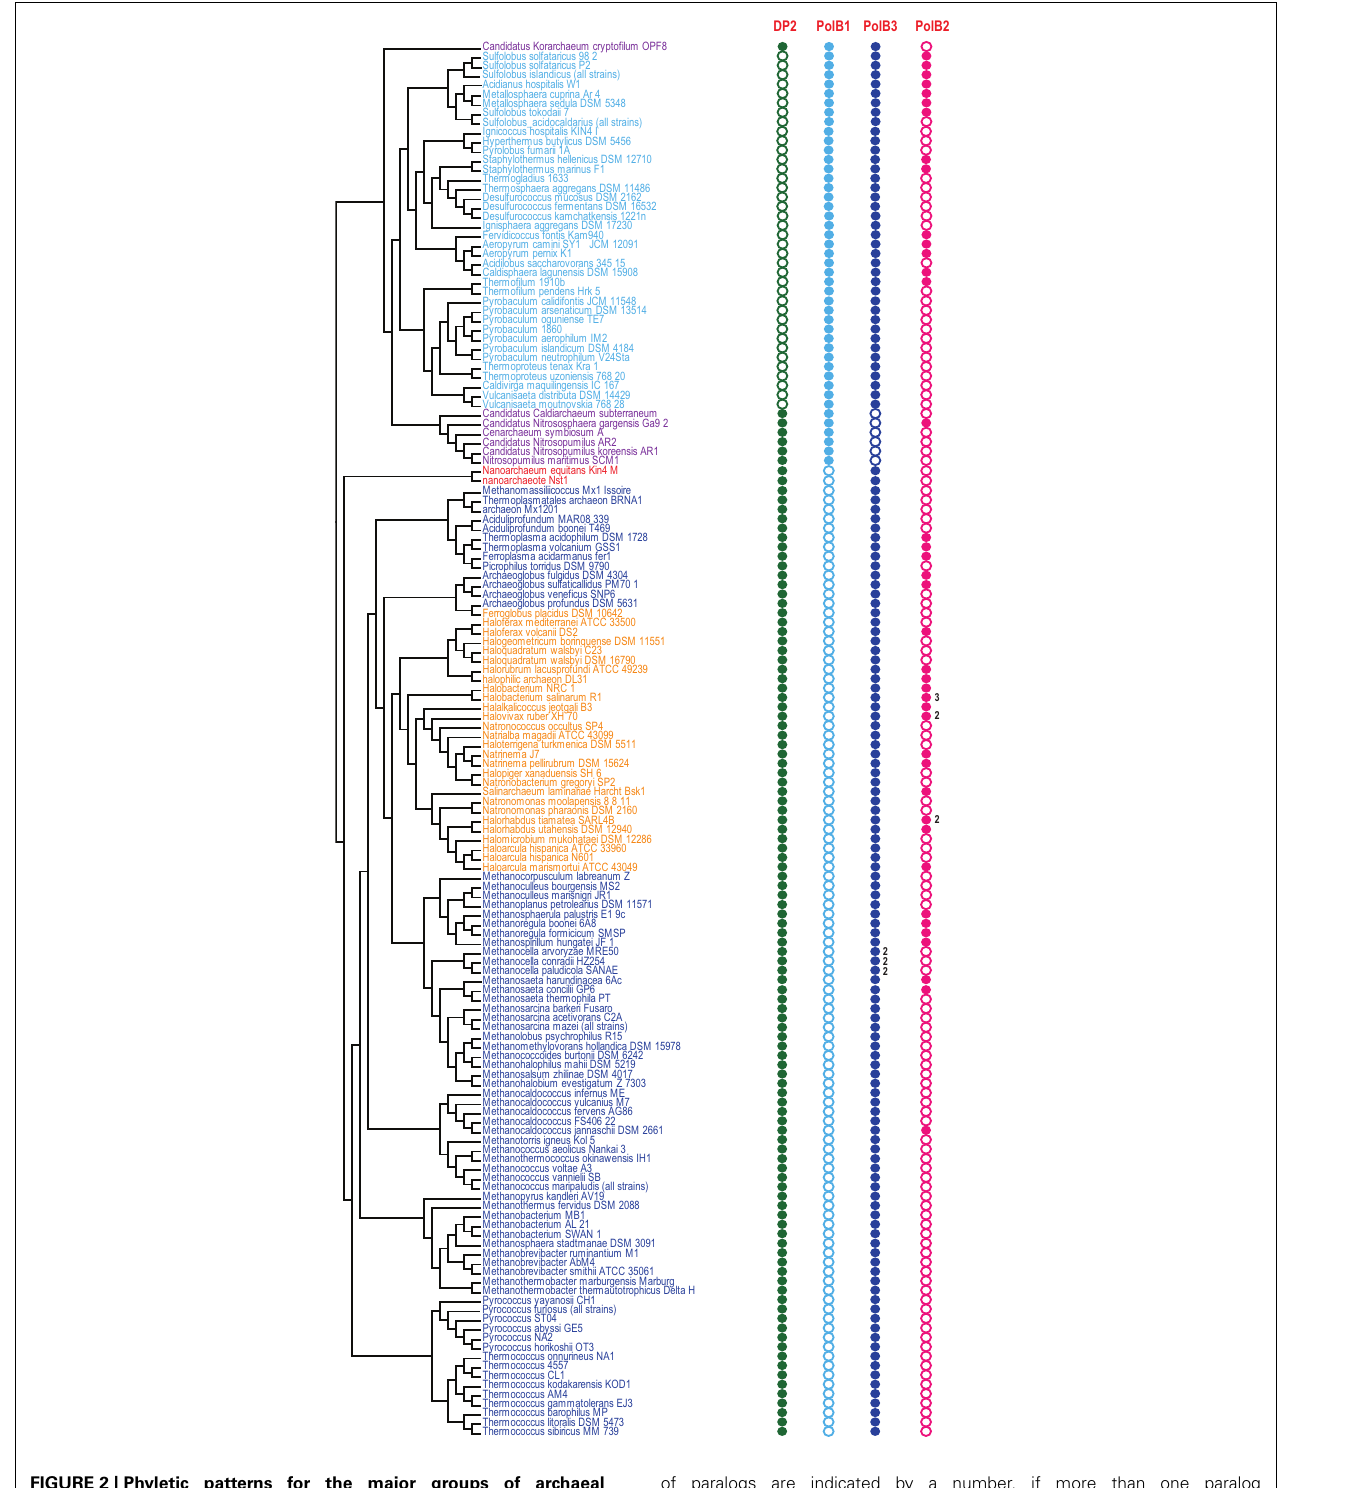
of paralogs are indicated by a number, if more than one paralog of the respective family is encoded in the genome. The tree topology is based on the phylogeny of concatenated ribosomal